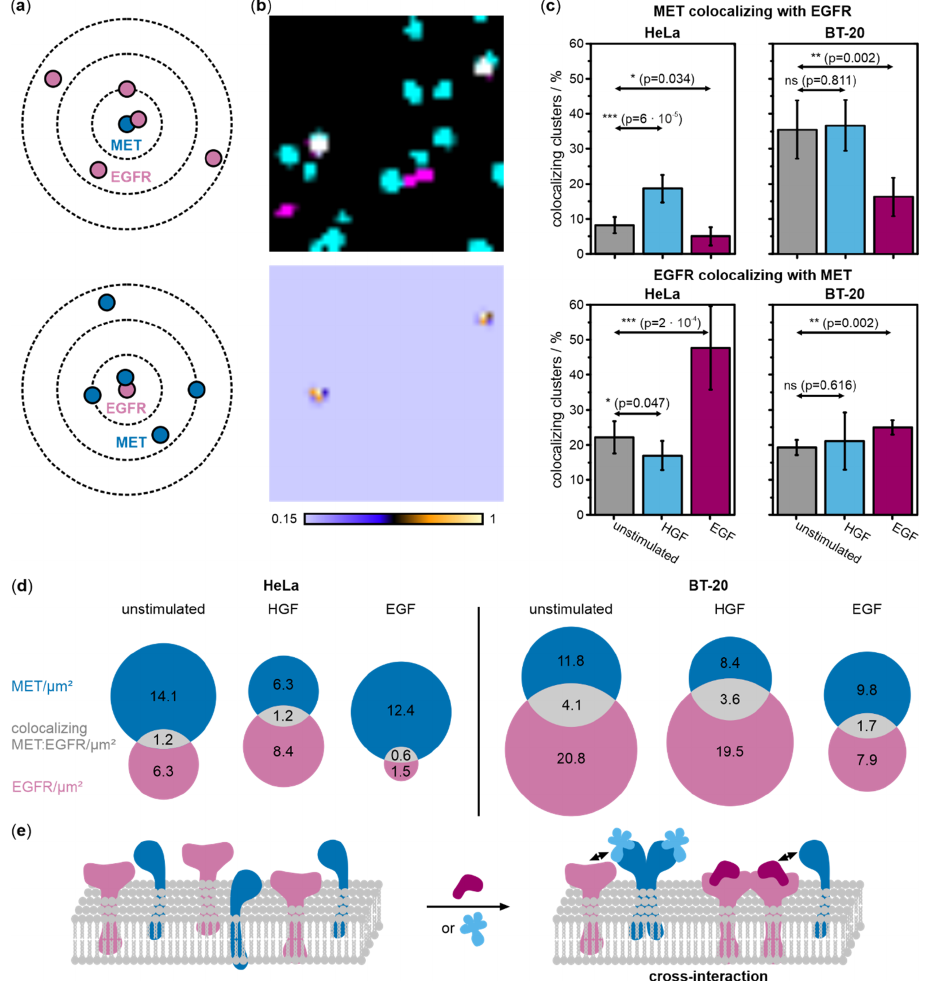
Figure 2. Coordinate-based colocalization analysis of DNA-PAINT data of MET and EGFR reveals increased receptor colocalization upon ligand stimulation in HeLa and BT-20 cells. ( a ) Representation of the principle of coordinate-based colocalization (CBC) of MET (cyan) and EGFR (magenta). For each receptor localization, the numbers and distances of surrounding receptors of the other species were determined (search radius r = 30 nm) and a distribution function calculated that reports on colocalization (–1 < CBC > 1). ( b ) Dual-color super-resolution images of MET and EGFR (top) were transformed into colocalization images (bottom) (0.15 < CBC < 1) (image sizes are 1 µm × 1 µm). ( c ) The relative amount of MET and EGFR colocalizing in single clusters in HeLa and BT-20 cells with respect to the total amount of the respective receptor in unstimulated (grey), HGF-activated (light blue), and EGF-stimulated (purple) cells. Values were averaged over 5 to 7 cells from at least three independent experiments. Error bars represent standard deviations. Results of two-sample t -tests for comparison of activated samples with the respective unstimulated sample are depicted as arrows ( p > 0.05 no significant di ff erence between populations (n.s.), p < 0.05 significant di ff erence (*), p < 0.01 very significant di ff erence (**), p < 0.001 highly significant di ff erence (***)). ( d ) Receptor cluster densities (per µ m 2 ) on the cell membrane of MET (cyan) and EGFR (magenta) together with colocalizing MET:EGFR clusters (gray) shown as Venn diagrams for HeLa and BT20 cells. Densities of co-localizing receptor clusters were calculated from an average of the number of co-localizing clusters in the MET and EGFR channel (see Materials and Methods). ( e ) A model of MET and EGFR cross-interaction upon stimulation with either EGF or